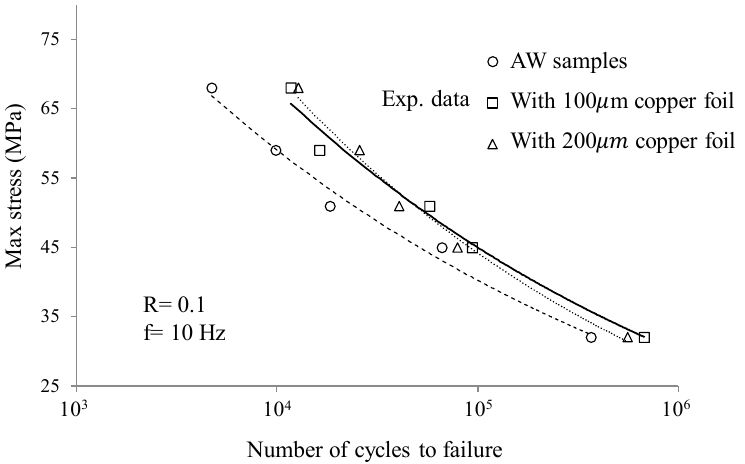
Figure 14. S–N curves of alloyed FSW samples with copper foil in the SZ and their comparison with that of as-welded samples.